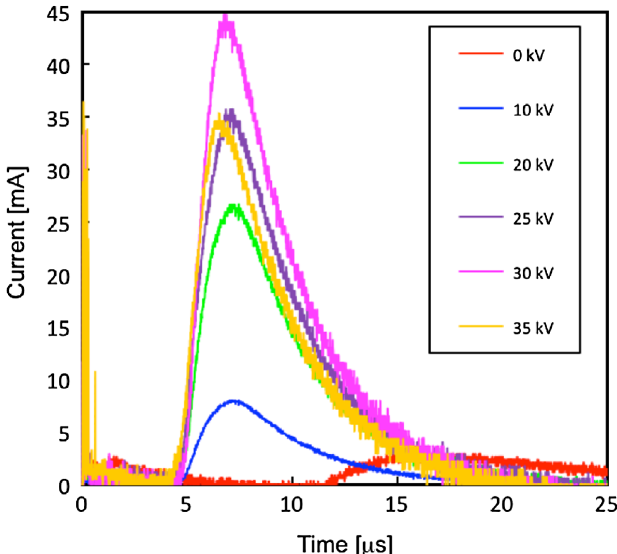
FIG. 32. Output waveform from beam channel 1 by extraction of the voltage of the plasma in the ion source (pickup voltage: 5.2 V; plasma input position: 6